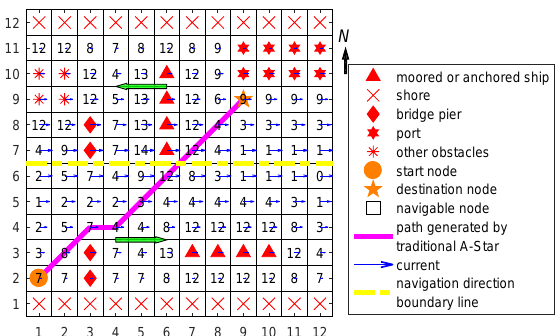
Figure 3. The grid map considering traffic